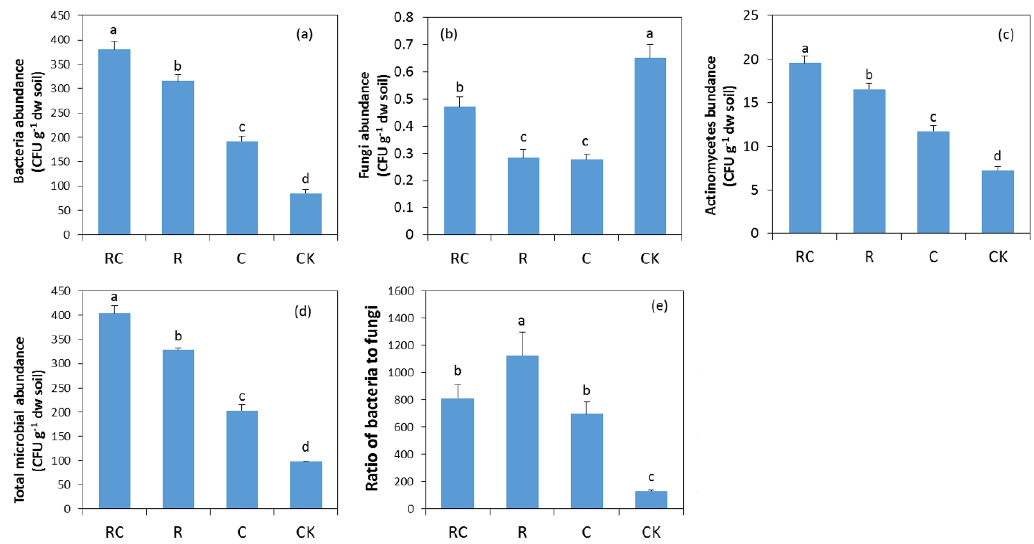
Figure 3. Soil bacterial abundance ( a ), fungal abundance ( b ), actinomycete abundance ( c ), total microbial abundance ( d ), and the ratio of bacterial to fungal abundance ( e ) under mixed rice straw and biochar addition (RC), rice straw addition (R), biochar addition (C), and control (CK) conditions. Values are the means of three replicates ( ± SE). Different letters indicate significant differences among the means of the different treatments.